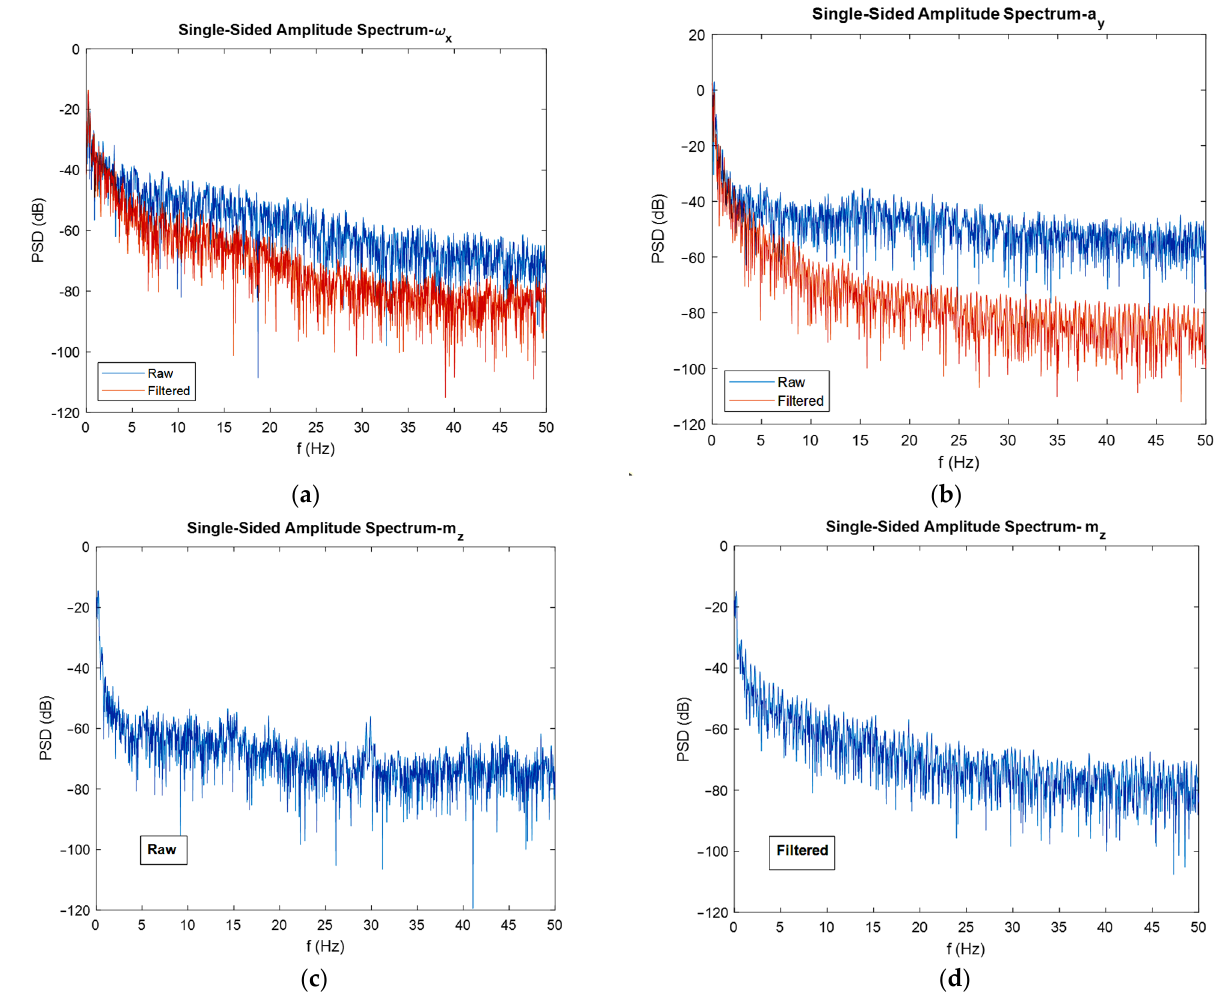
Figure 17. FFT diagrams for moving gyroscope, accelerometer ( a , b ), and magnetometer ( c , d ).